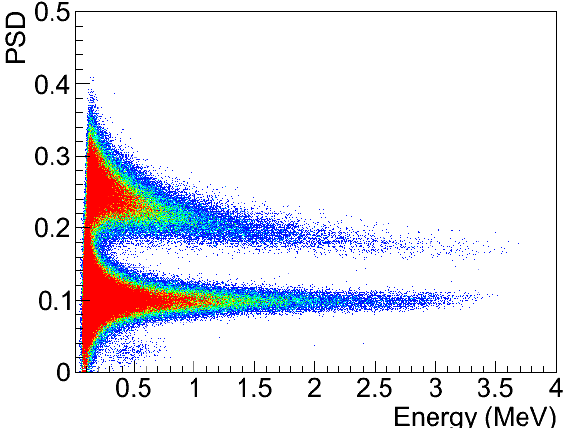
Fig. 3. Pulse Shape Discrimination Plot obtained by a CAEN desktop digitizer with a EJ309 liquid scintillator detector coupled to a flat panel Hamamatsu. The gamma region is between 0.0 < PSD < 0.2 and the neutron region is between 0.2 < PSD < 0.4. PSD = (long gate integration – short gate integration)/ long gate integration..